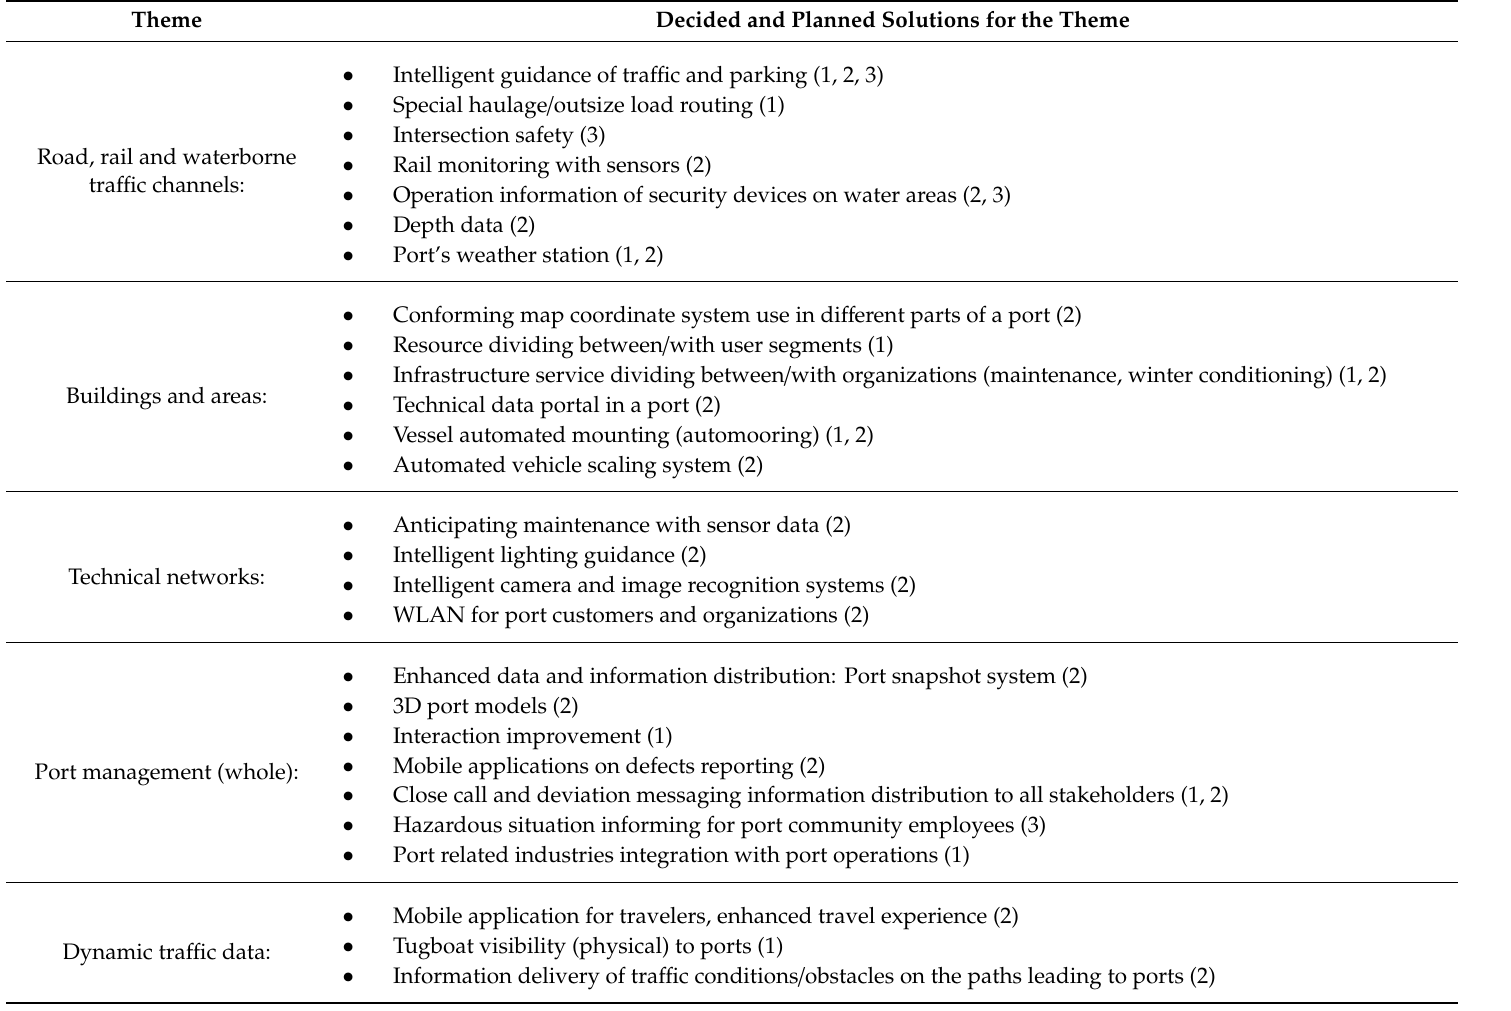
Table 2. Digital solutions identified by the studied ports (numbers in brackets refer to the main category of arguments presented after Table